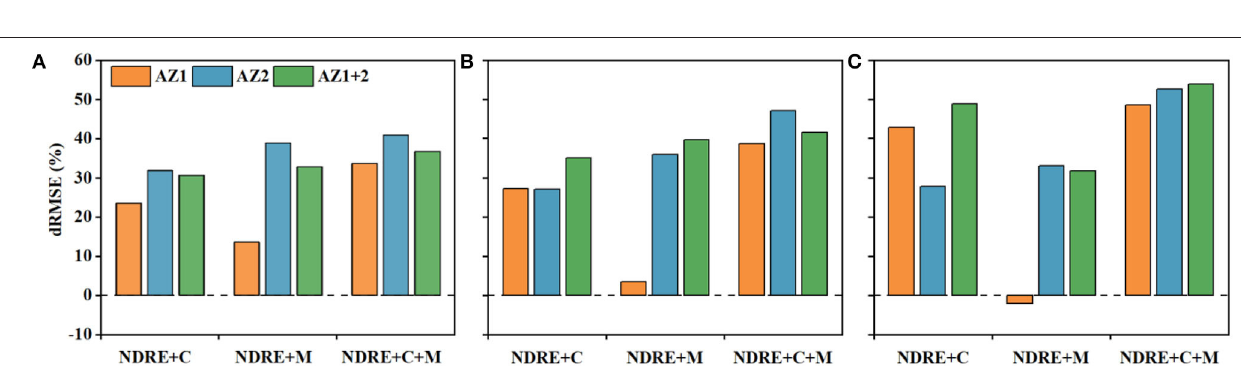
Frontiers in Plant Science |